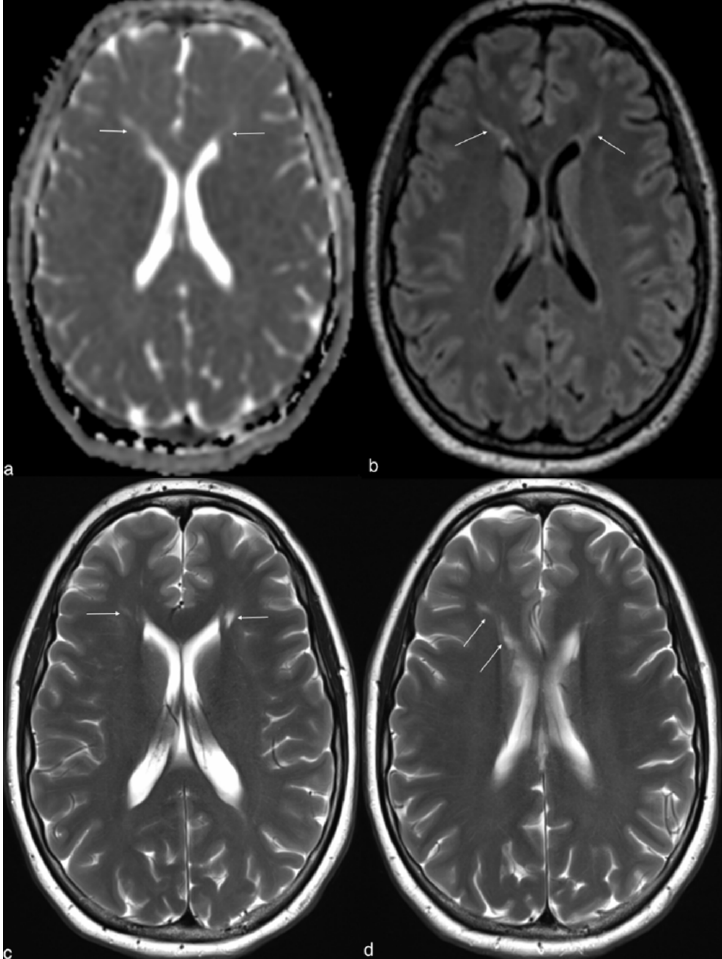
Figure 1. Brain MRI shows an increased ADC (arrows in ( a )) associated with linear high signals lesions of the white matter in front of the frontal horns of lateral ventricles on FLAIR and T2 (arrows in ( b – d )). ADC, apparent diffusion coefficient; MRI, magnetic resonance imaging. MRSI with 5-mm isotropic resolution [17] (TR 355 ms, TE 0.65 ms, quantification with LCModel, http://s-provencher.com/lcmodel.shtml, accessed on 11 January 2022) was performed over the patient whole brain and compared to 5 controls (Figure 2a). N -acetylaspartate + N -acetyl aspartylglutamate (tNAA), creatine + phosphocreatine (tCre), choline moiety metabolites (Cho) (choline, acetylcholine, phosphocholine and glycerophos- phocholine), myoinositol (mIns), and glutamate + glutamine (Glx) were measured against data from 5 controls in the anatomical structures of the brain (Figure 2b). This showed a markedly reduced mIns/tCre ratio ( − 45% in average overall structures, Z-score = − 5.5) and Cho/tCre ratio ( − 26%, Z-score = − 2.1) over all brain structures. Surprisingly other metabolites (tNAA/tCre ratio and Glx/tCre ratio) showed no difference with control values (Z-score = − 0.2, − 0.16,